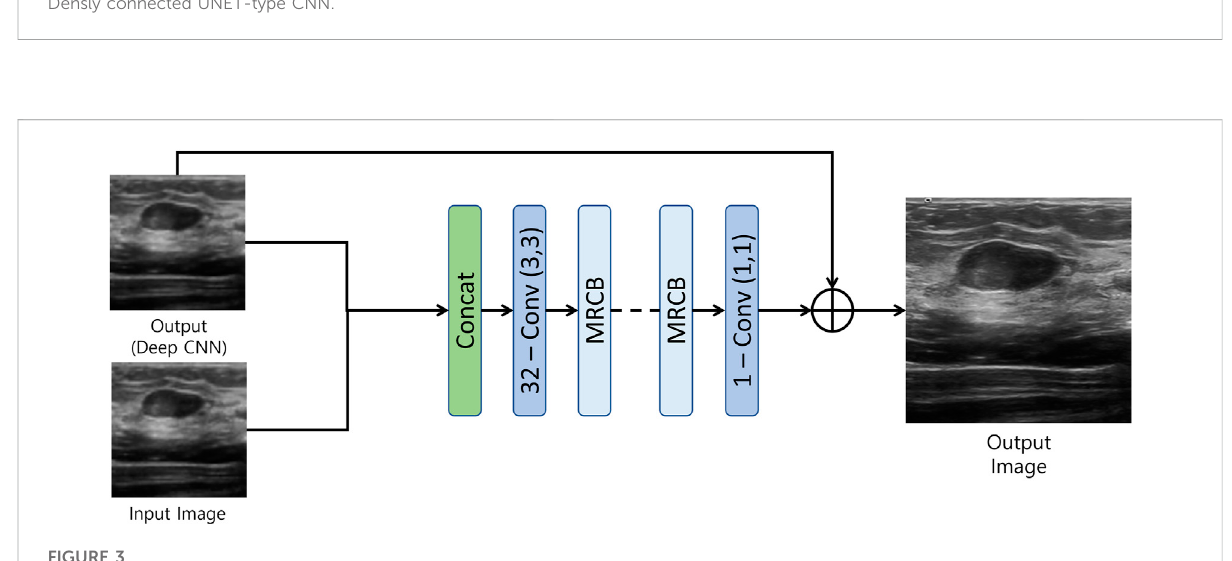
FIGURE 3 Resolution/Texture enhancement